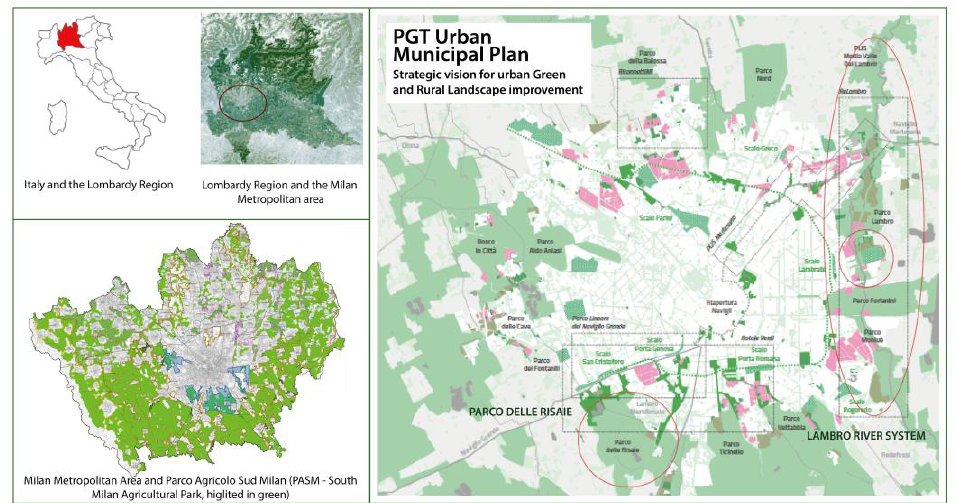
Figure 3. The metropolitan context of Milan. The figure highlights the South Milan Agricultural Park and the green and rural landscapes strategies of the Municipal Plan of Milan (with the selected practice localization).